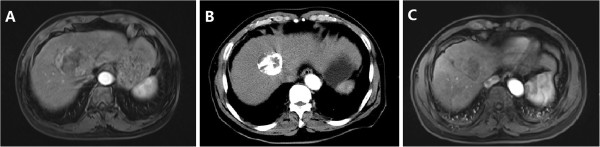
Complete ablation of HCC. A: MRI image before TACE; B: CT image before RFA; C: MRI image after RFA.